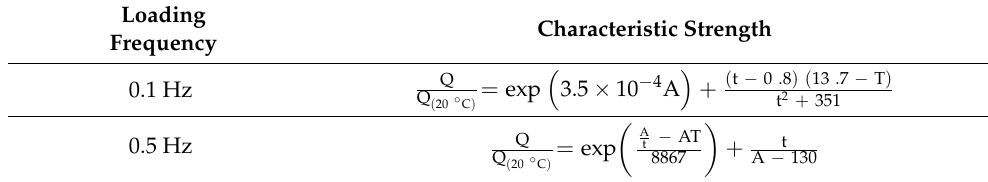
Table 5. The proposed empirical expressions for LRB’s characteristic strength at low ambient temperatures.